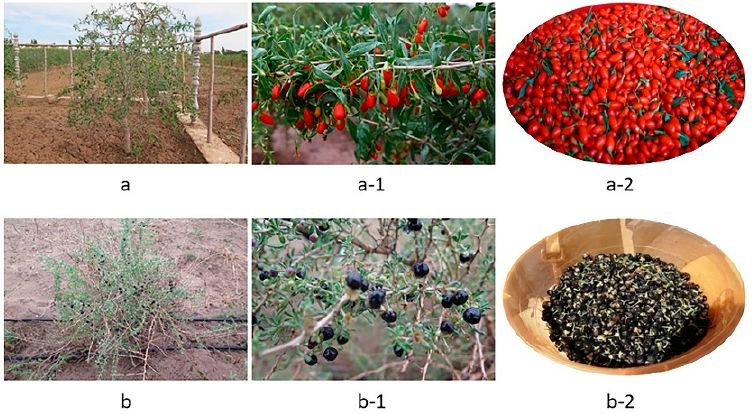
Figure 1. Physical appearance of the studied Lycium species. ( a ) Wolfberry plant with red fruit; ( a-1 ) characteristic red wolfberry fruit; ( a-2 ) commercial red wolfberry. ( b ) Wolfberry plant with black fruit; ( b-1 ) characteristic black wolfberry fruit; ( b-2 ) commercial black wolfberry. ( c ) A CFDA-ap-